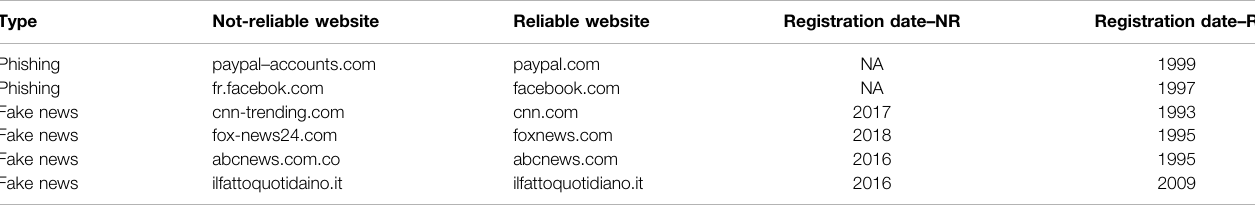
TABLE 6 | Comparison of not-reliable (NR) and reliable (R) websites. Alongside lexical features, domain name ’ s registration date (extracted from WHOIS) can be relevant to spot fake websites.